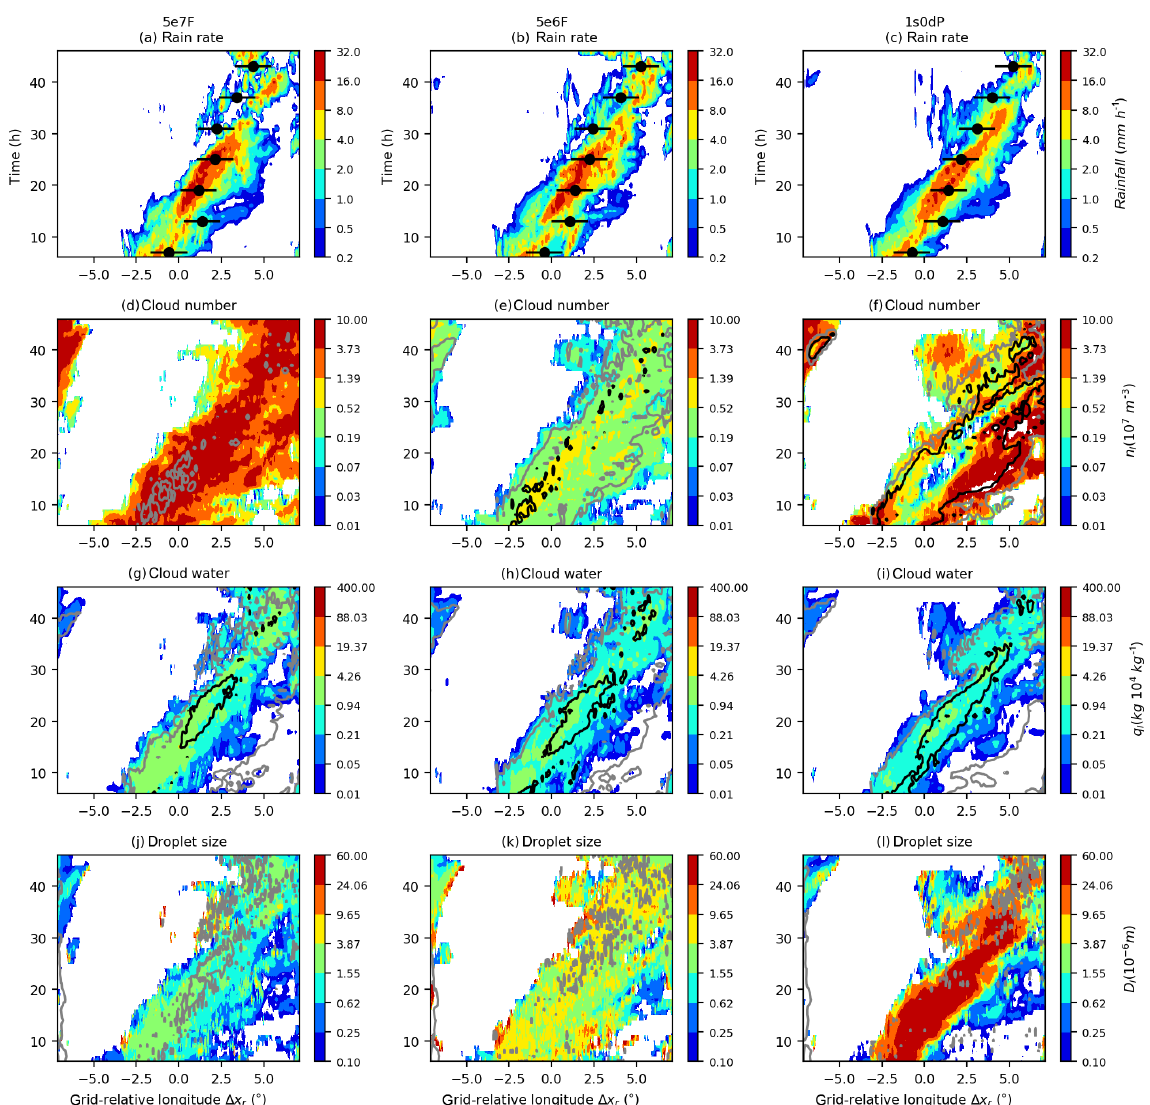
Figure 3. Rotated-longitude–time plots of surface-rainfall rate (a, b, c) , cloud-droplet number concentrations (d, e, f) , mass concentrations (g, h, i) and cloud-droplet size (j, k, l) at a hybrid height of 3405m in the grid-relative longitude, (cid:49)x r . The results from three models are shown: 5e7F (a, d, g, j) , 5e6F (b, e, h, k) and 1s0dP (c, f, i, l) . The colours show the rainfall rate, the mass/number concentrations and the mean sizes, according to the adjacent scales. The solid black and grey contours are lines of constant raindrop mass, number or size. The decorated black circles in panels (a, d, g) show the locations at 3h intervals of a 2 ◦ × 2 ◦ box centred on the moving centroid of the surface-rainfall-rate